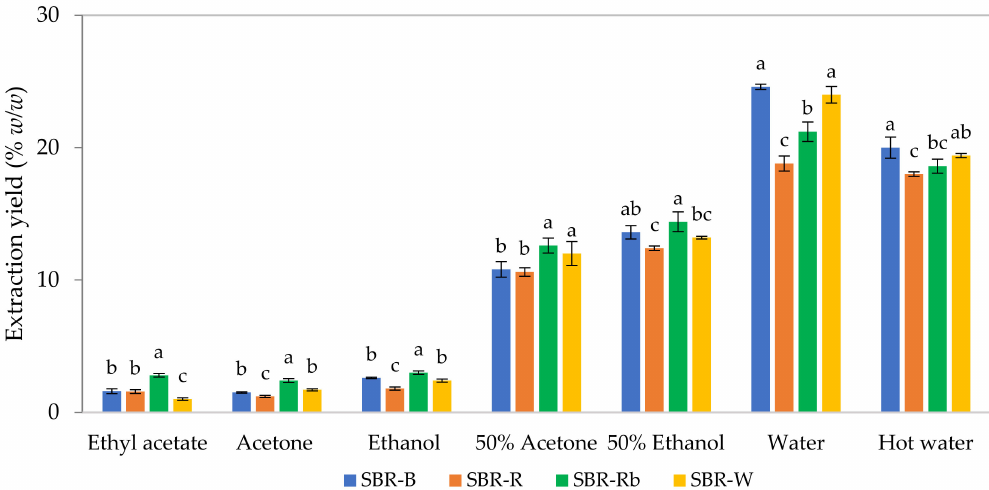
Figure 2. Extraction yield of crude extracts from solid-based residues (SBRs) prepared using different solvents. Different superscript letters compared within the same solvent are significantly different based on Tukey’s test ( p <